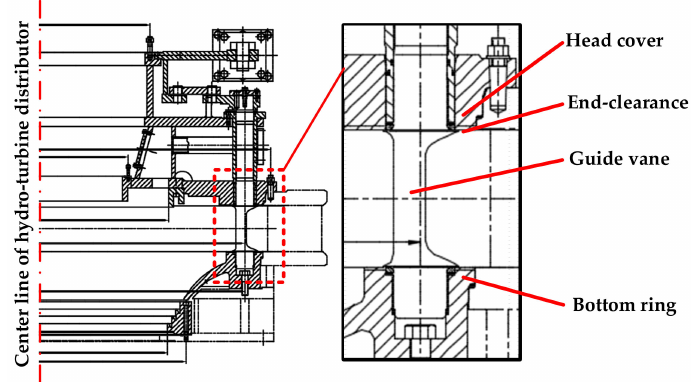
Figure 4. Schematic diagram in the end-clearance of a turbine guide